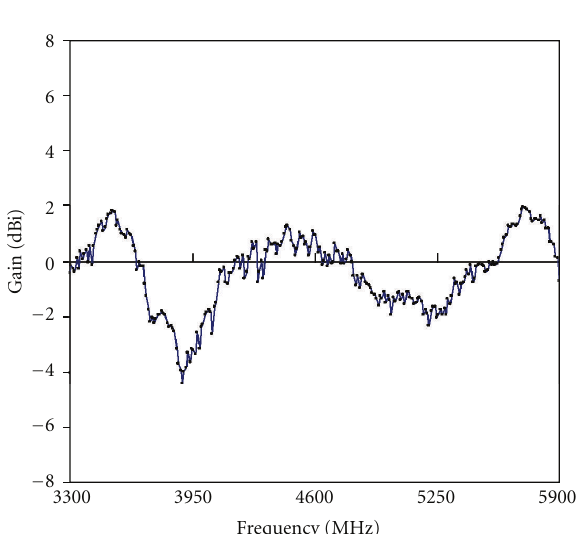
Figure 11: Measured gains of hybrid DR antenna gain for operating frequencies from 3.3 to 5.9